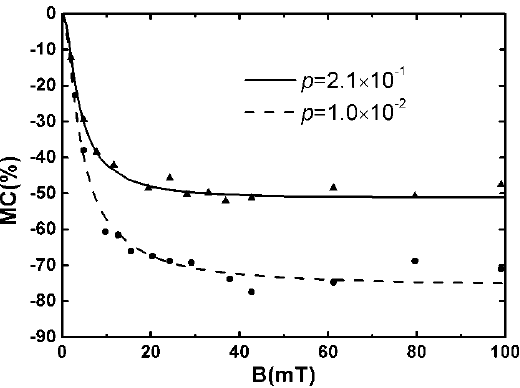
Figure 18. Dependence of the magnetic conductance on the magnetic field at different polaron concentrations by Yang et al. [68] with the permission of the Journal of Chemical Physics. Triangles and dots are experimental data [69].